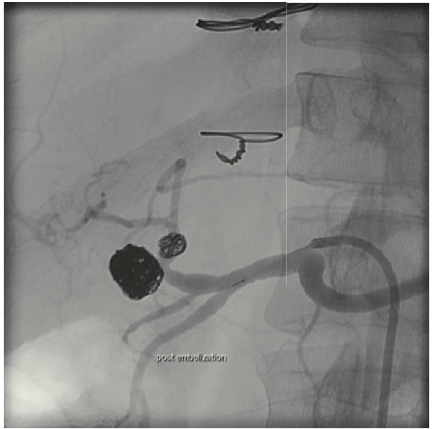
coiling and successful embolization with nine coils in right hepatic artery aneurysm and four coils in left hepatic artery aneurysm (Figure 2).